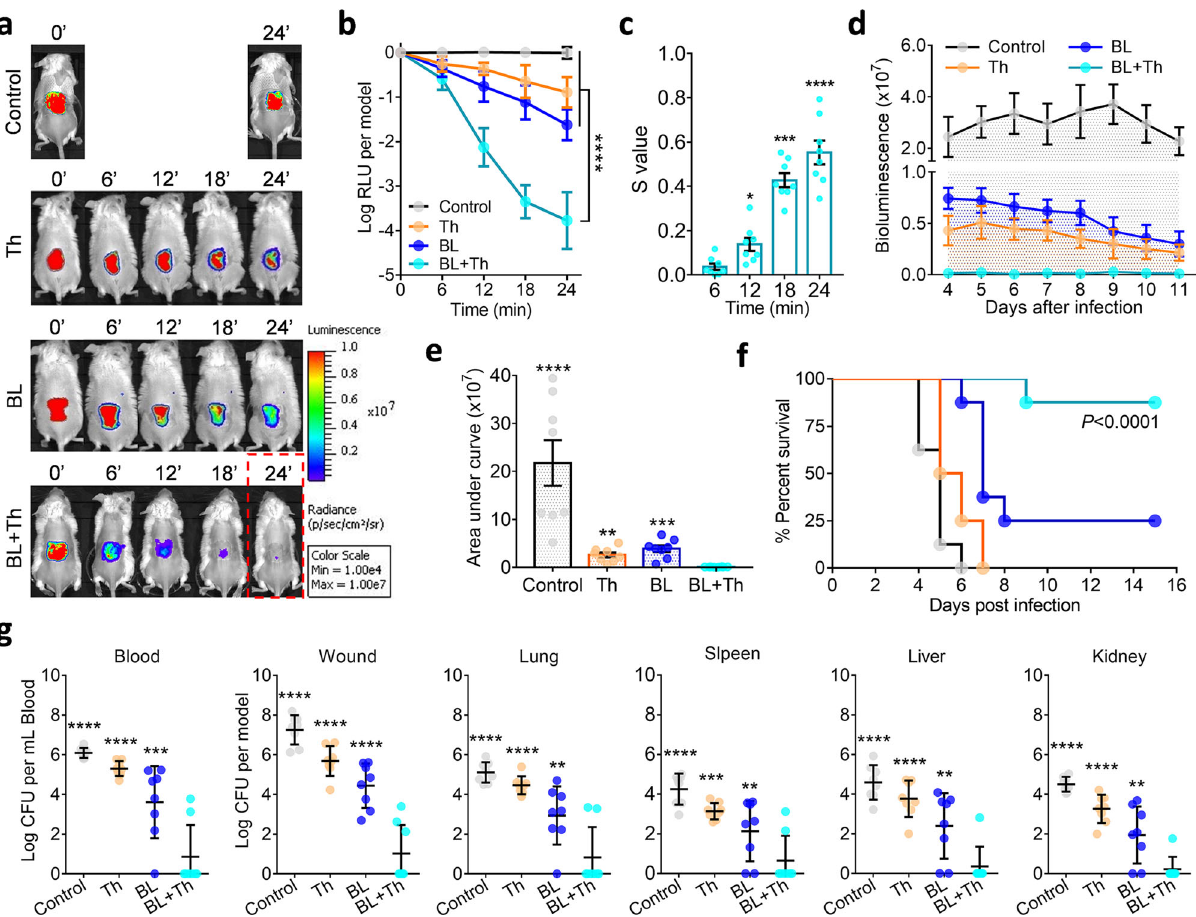
Fig. 4 BL together with thymol rescues mice from lethal USA300 bio fi lm-associated infection. Murine 3rd-burn-wounds were infected with USA300 at 5 × 10 7 CFU in 50 µ L of PBS for 72 h to form mature bio fi lms. The infected wounds were treated with sham (control), 50 µ L of thymol at 10 mg/mL